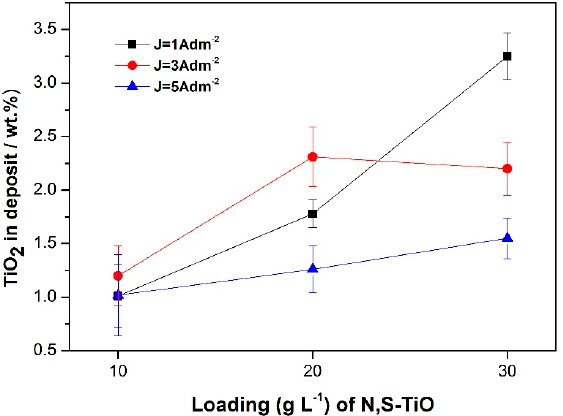
Figure 6. Variation of the weight percentage of N,S-TiO 2 particles embedded within the alloy matrix as a function of loading of TiO 2 particles in the bath (10, 20, and 30 g·L − 1 ) for various current density values.